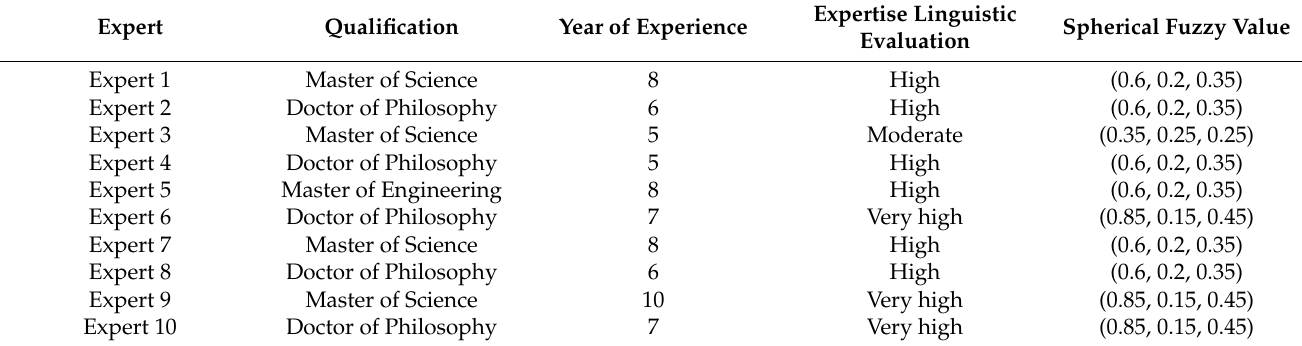
Table A3. Expert’s qualification and linguistic